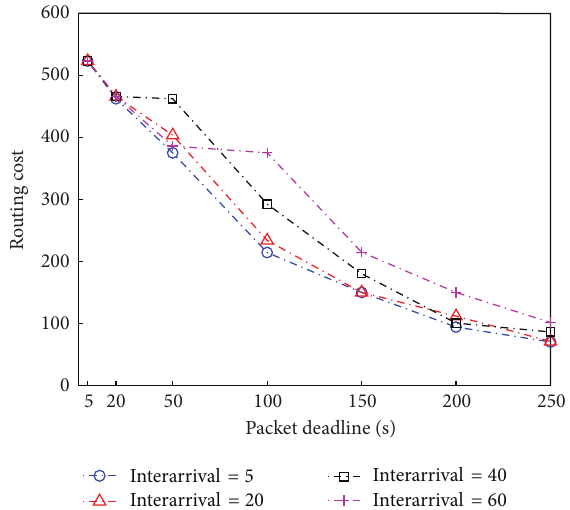
Figure 7: Packet delivery delay with respect to packet deadline and mobile nodes’ interarrival time.